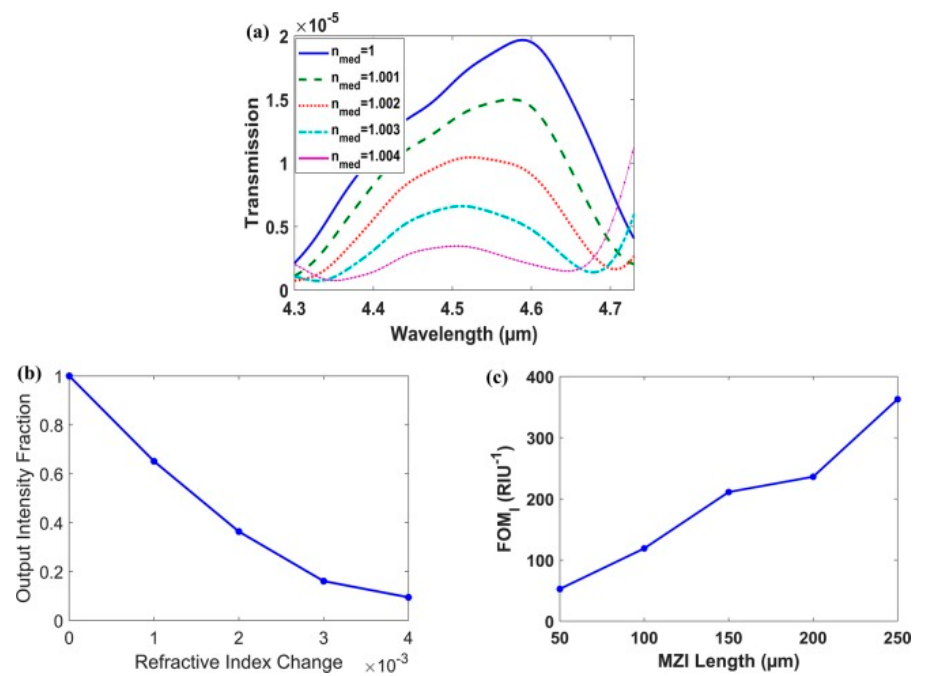
Figure 10. Vertical plasmonic MZI with D = 1000 nm, T = 2000 nm, h HIL = 320 nm, w 1 = 2100 nm, w 2 = 1800 nm, P gr = 918.4 nm and h gr = 450 nm. ( a ) Transmission spectrum at different medium indices at L = 250 µ m. ( b ) Output Intensity Fraction around λ = 4.6 µ m versus air medium refractive index change ( ∆ n med ) at L = 250 µ m. ( c ) Intensity interrogation FOM 1 versus MZI length around λ = 4.6 µ m. Reprinted with permission from Ref. [115].